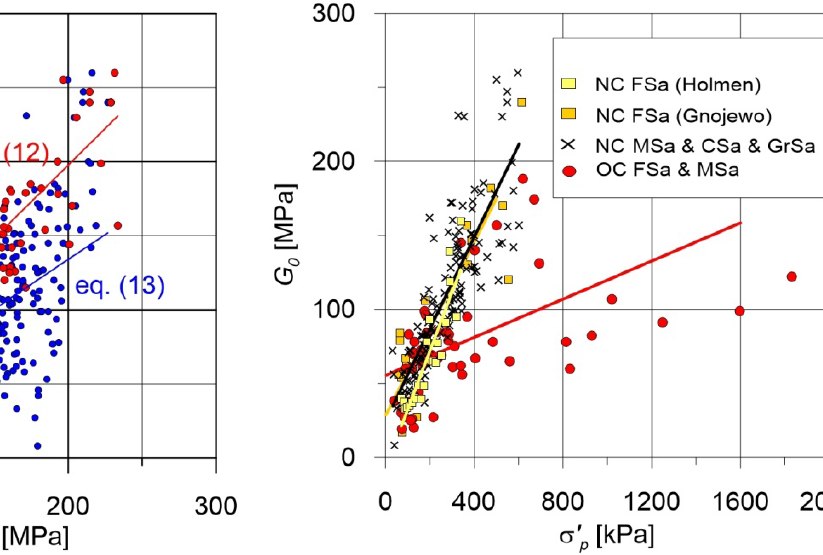
values measured and calculated on the Figure 11: Comparison of G 0 basis of Eqs. (7–12) (red) and Eq. (13) (blue).